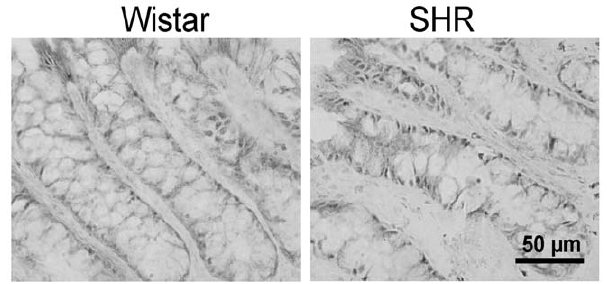
Figure 4. Immunostaining of BMAL1 protein in the colonic epithelium of Wistar rat (left) and SHR (right). Localization of immunopositive cells along the colonic crypt was similar in both rat